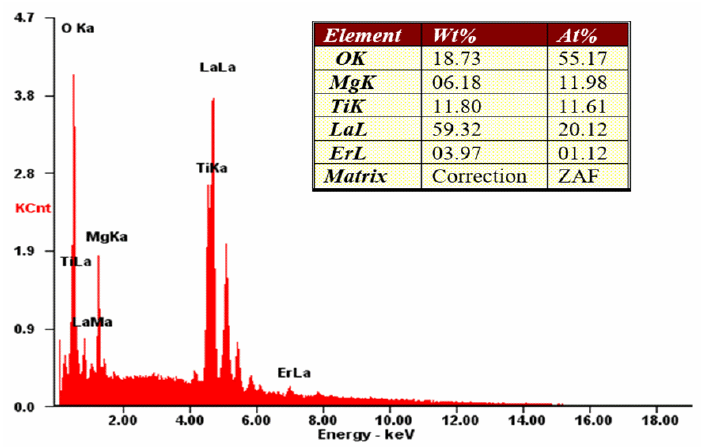
Figure 3. Results of EDS X-ray microanalysis of La 2 MgTiO 6 :5% Er 3+